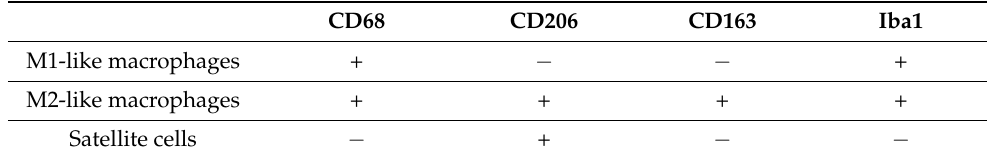
Table 1. Cell phenotypes.